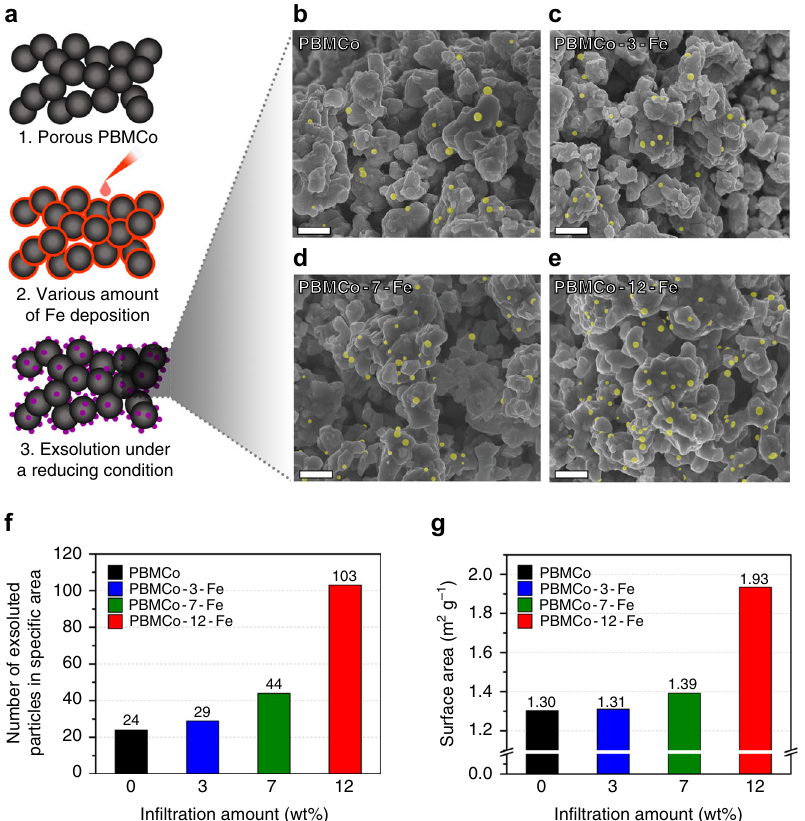
Fig. 2 Scanning electron microscopy images and population of exsolved particles. a Sample preparation process for con fi rming the correlation between the amount of in fi ltrated Fe and the population of exsolved nanoparticles. b – e SEM images of b PBMCo, c PBMCo-3-Fe, d PBMCo-7-Fe, and e PBMCo-12-Fe (exsolved nanoparticles are highlighted in yellow); scale bars are 500 nm. f Number of exsolved particles in speci fi c area counted by Image J. g Speci fi c surface area calculated by the BET